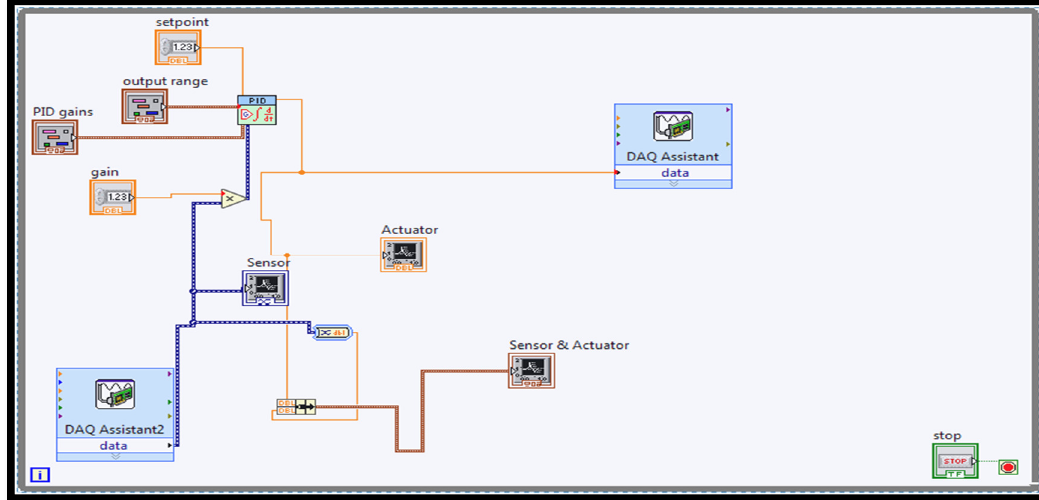
Fig. 7. Block diagram of the controller used in this work .